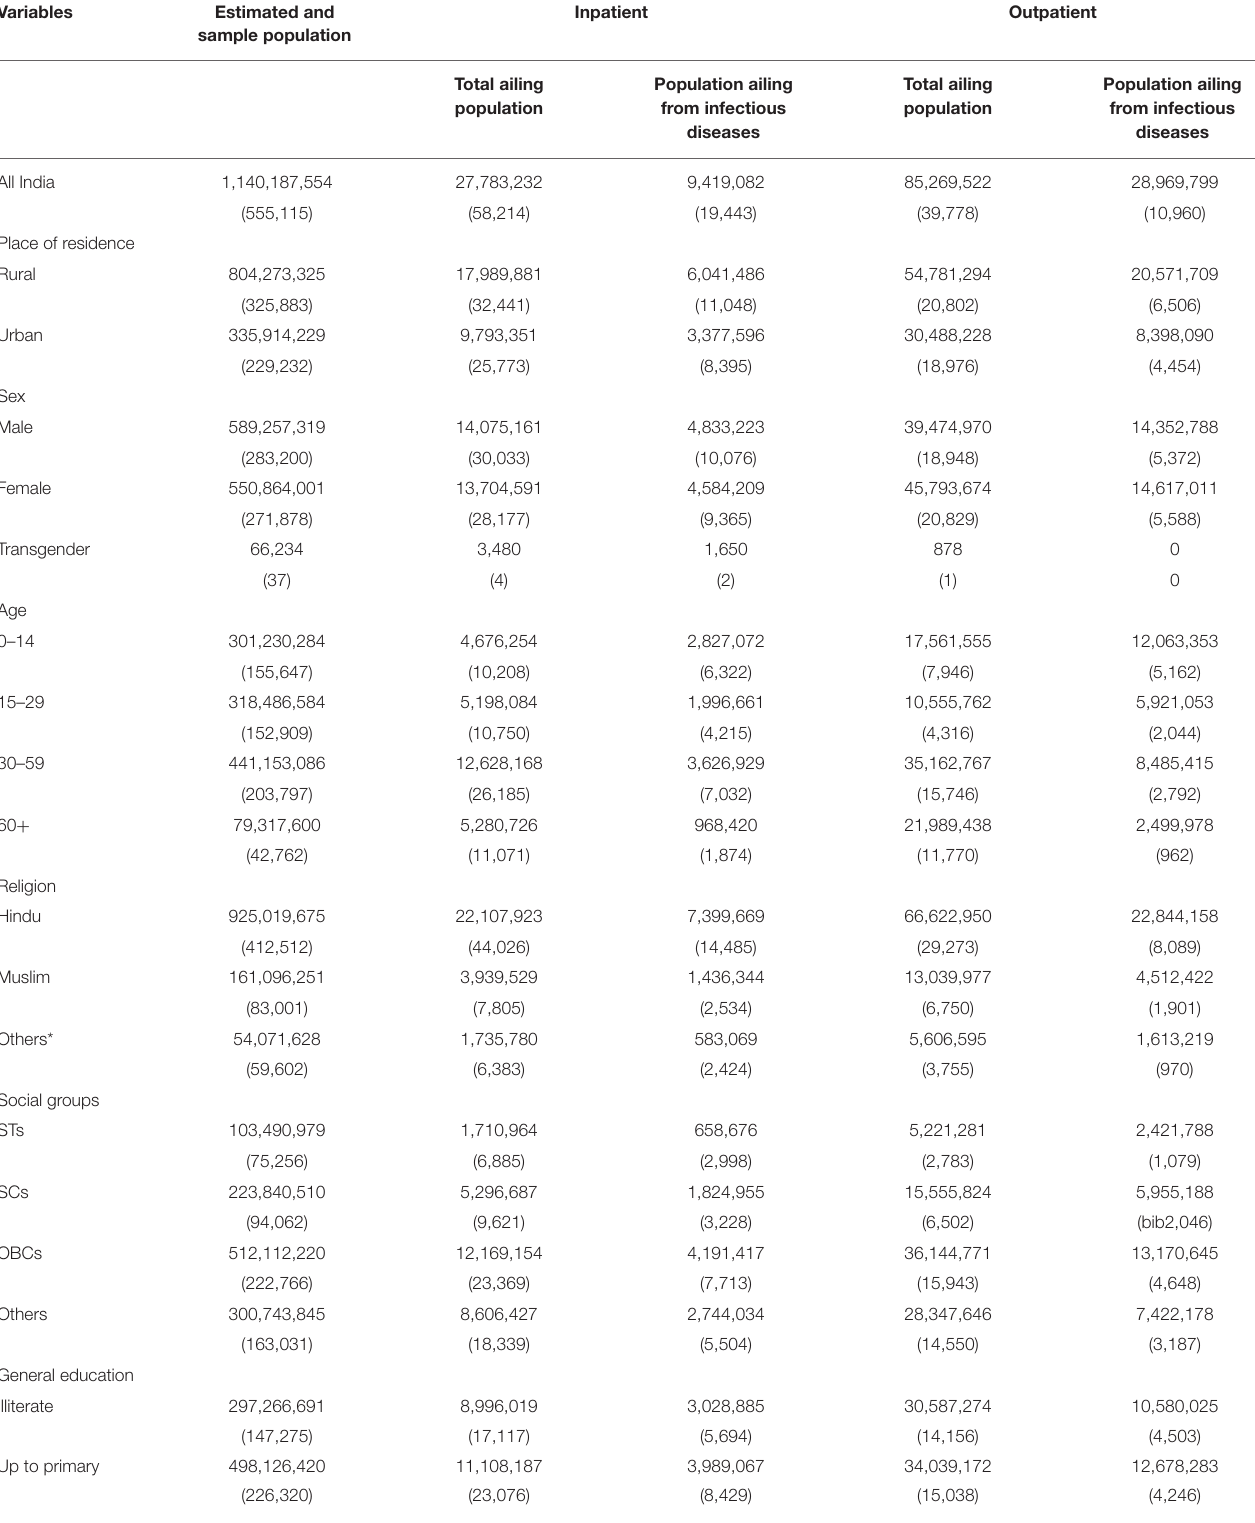
TABLE 1 | Summary statistics of the sample population.